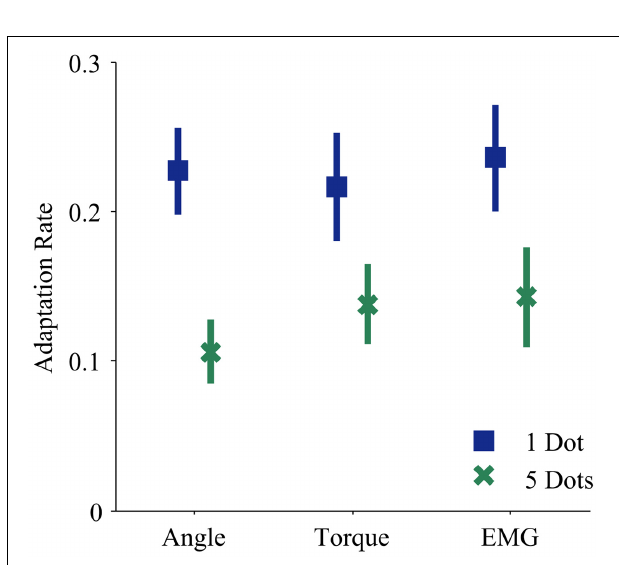
minimum mean error to the maximum mean error across subjects. (B) Regression between adaptation rate and error across control interfaces for low feedback uncertainty (solid line), and high feedback uncertainty (dashed line). Shaded areas represent 95% confidence intervals of regression.